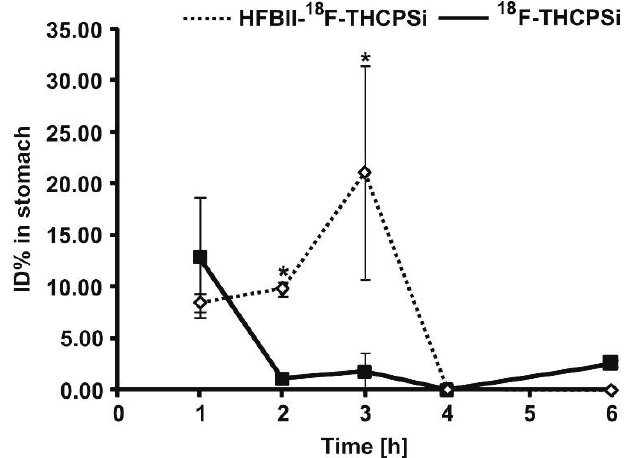
Figure 8. Comparison of gastric emptying time of HFBII- 18 F-THCPSi and non-functionalised 18 F-THCPSi nanoparticles in rats. ID% is the percentage of injected dose, which was calculated from the radioactivity of the gastric tissues. Data represent mean ± standard deviation ( n = 3 per time point), *: p < 0.05. Reprinted from Sarparanta et al. [109] with permission of Elsevier.